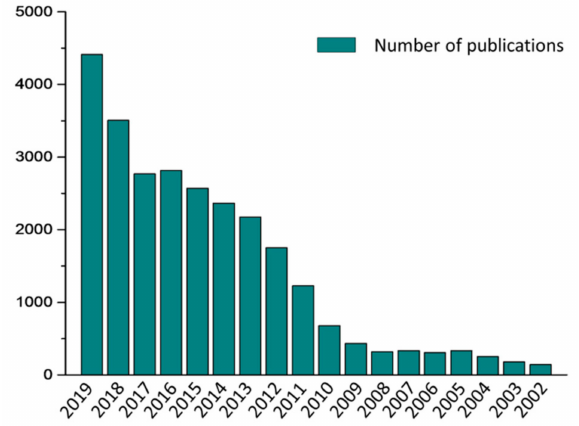
Figure 1. Statistics on the number of published journals on pH-sensitive biomaterials over the past 20